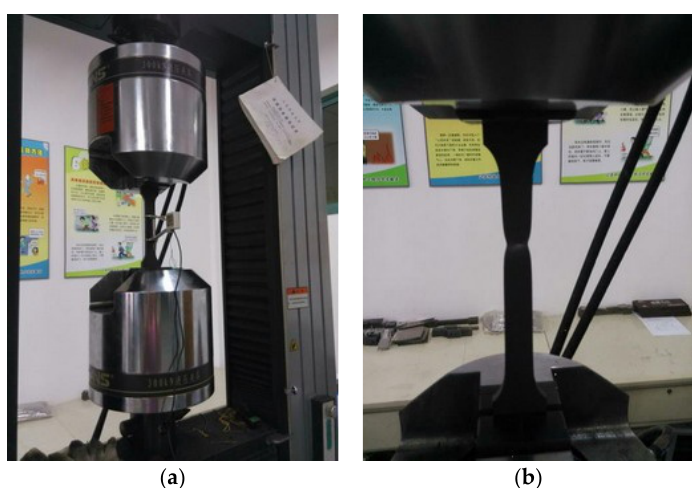
Figure 6. Material tensile test: ( a ) Installation; ( b ) Fracture.